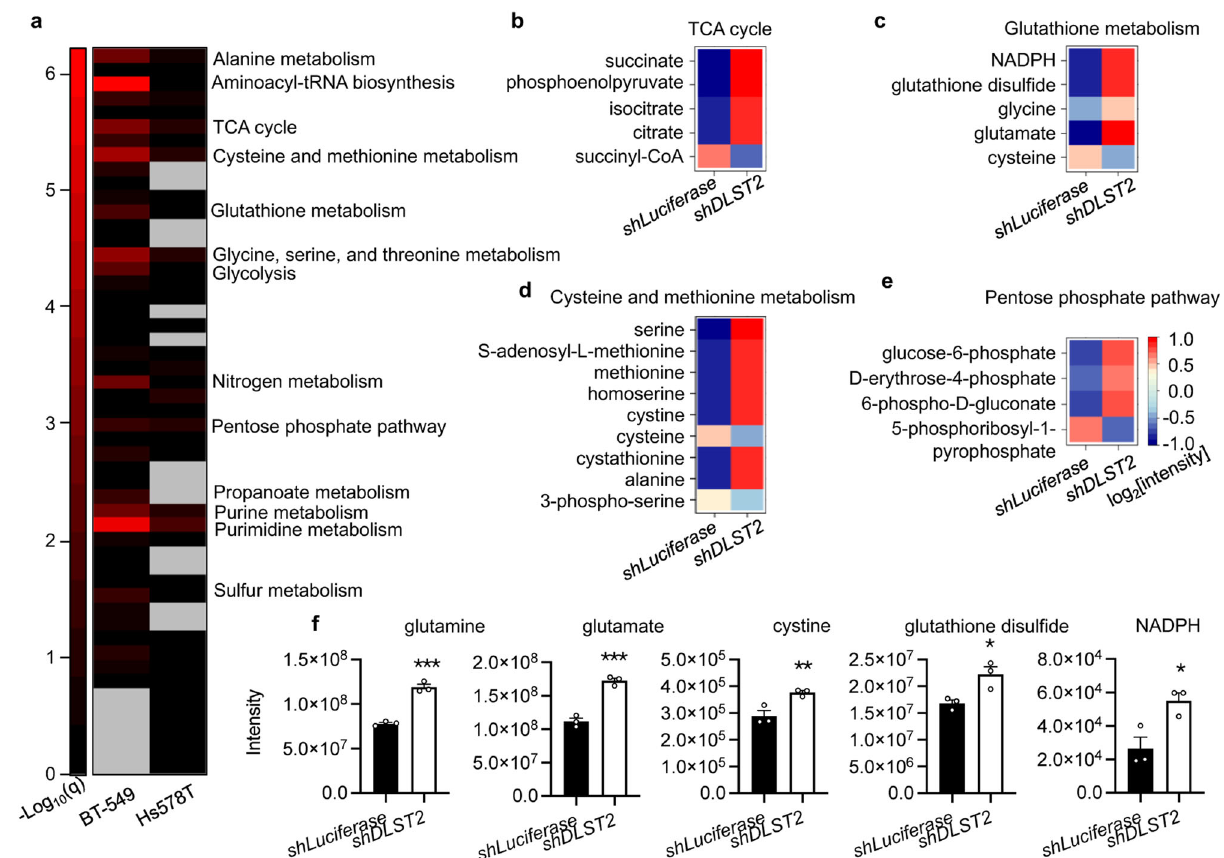
Fig. 4 DLST knockdown signi fi cantly alters multiple metabolic pathways in DLST-dependent TNBC cells while minimally affecting independent ones. a Pathway enrichment analysis of unlabeled metabolomics pro fi ling data in BT-549 and Hs578T cells. Missing values were represented by gray color. The enrichment score is represented as − log10( q -value). b – e The log2 values of normalized metabolite intensity in the pathways indicated are shown as the heatmap for BT549 cells ( n = 3 independent experiments): TCA cycle ( b ), glutathione metabolism ( c ), cysteine and methionine metabolism ( d ), and pentose phosphate pathway ( e ). f Representative metabolites related to redox balance are shown in BT-549 cells after DLST knockdown ( n = 3). Data are presented as mean ± s.e.m, and an unpaired two-tailed t -test was used for statistical comparison. * P ≤ 0.05, ** P ≤ 0.01, *** P ≤